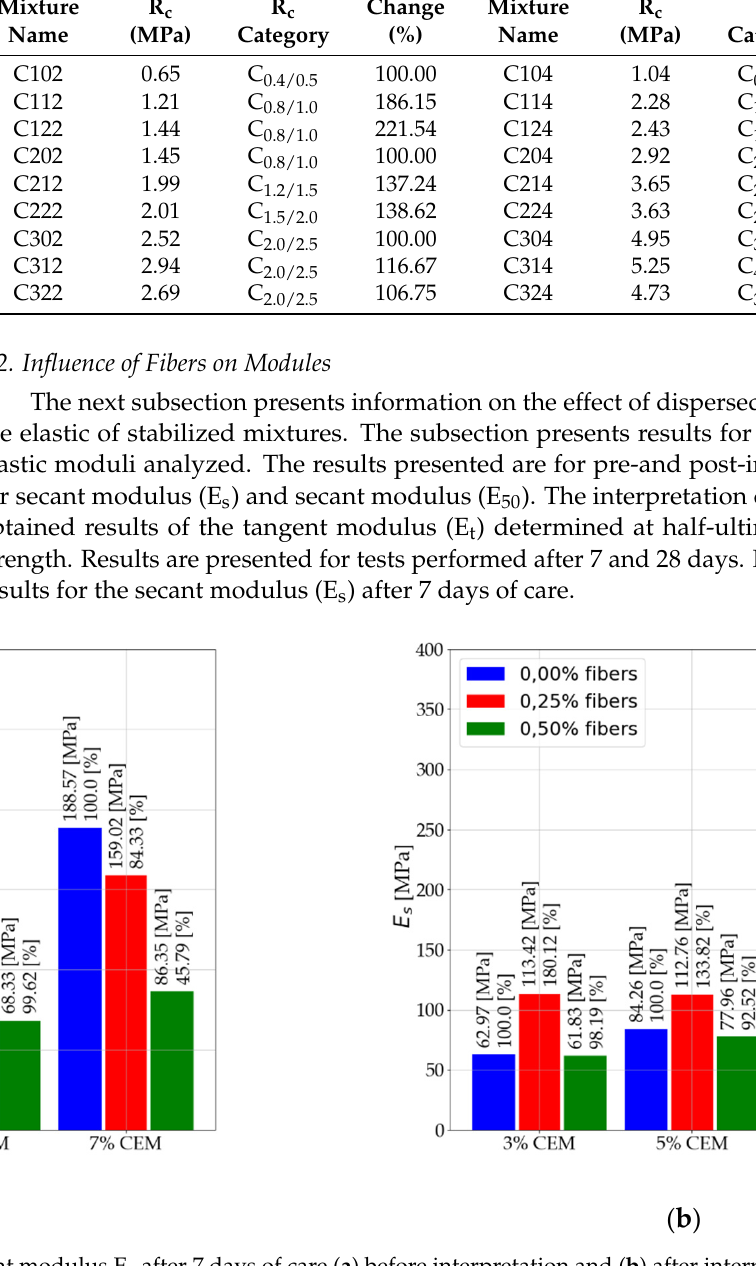
Figure 6. Values of secant modulus 𝑬 𝒔 after 7 days of care ( a ) before interpretation and ( b ) after interpretation.